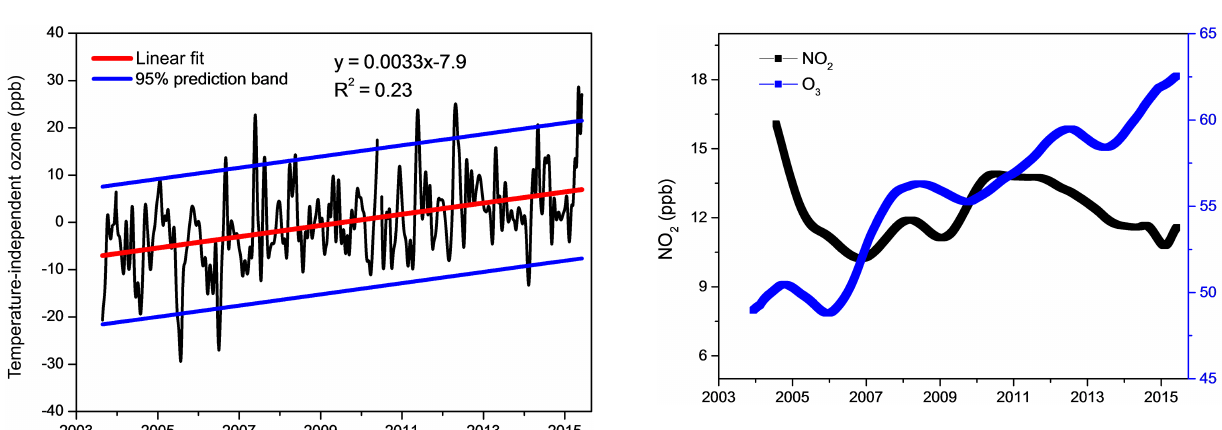
Figure 8. Long-term trends of NO 2 and the MDA8 ozone value calculated by KZ 365 , 3